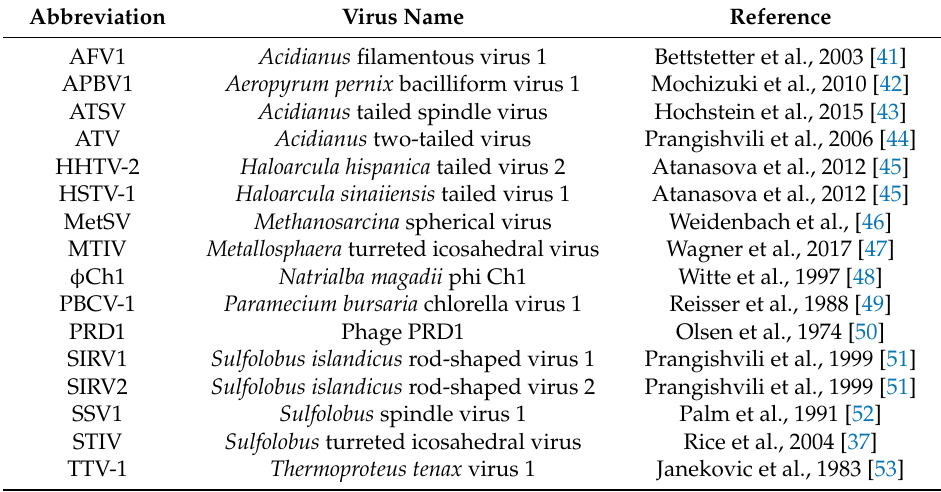
Table 2. Table of all viruses mentioned in this review, their abbreviation, and the original reference where the virus is